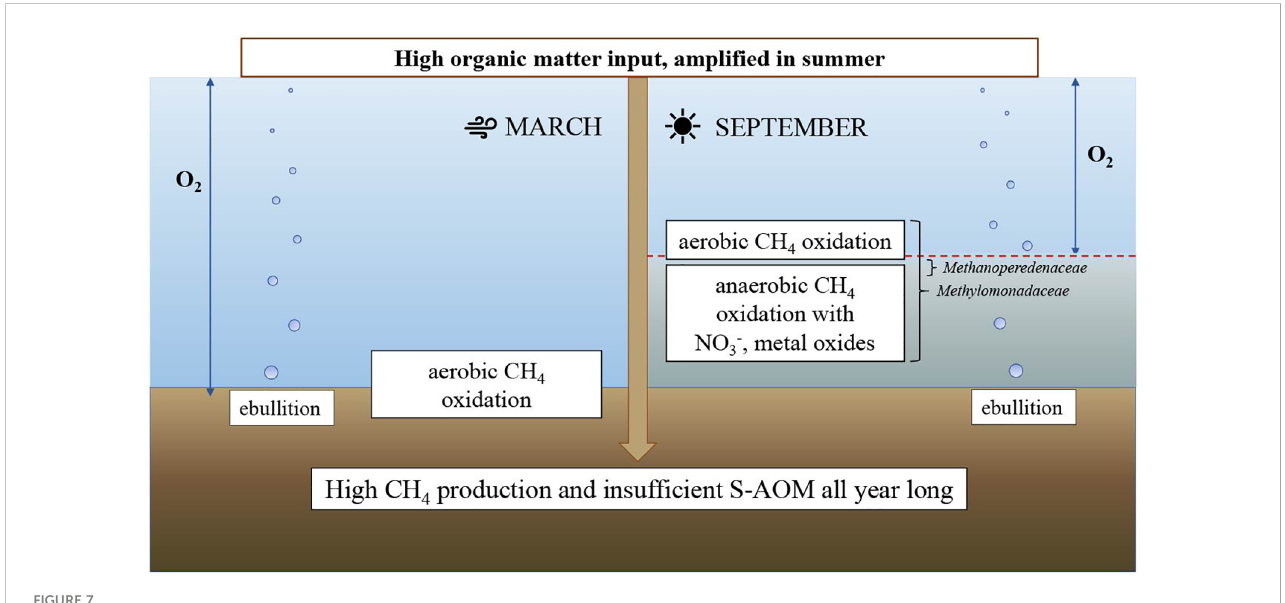
FIGURE 7 Schematic of seasonal changes in methane dynamics at Scharendijke in